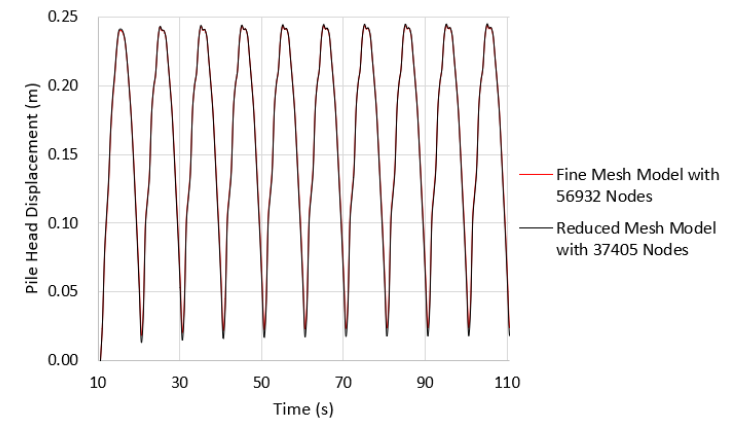
Figure 8. Time history of the pile head displacement in the sensitivity